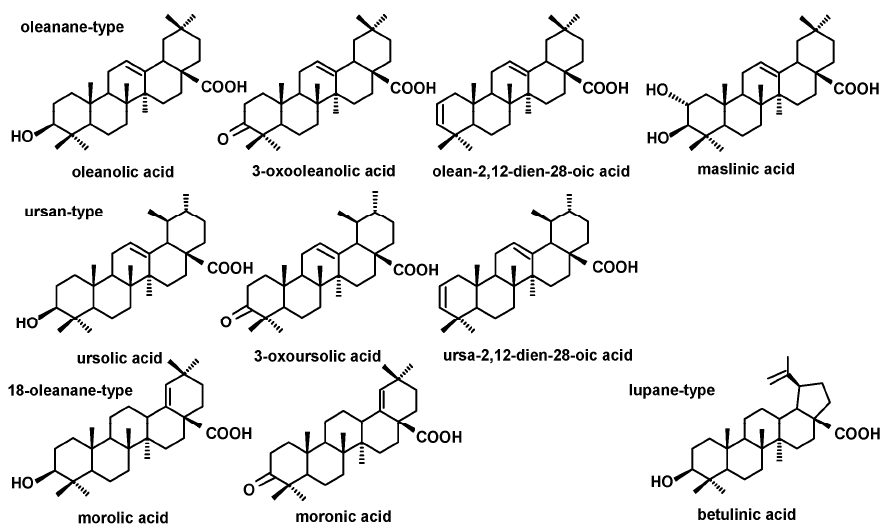
Figure 3. The structures of identified triterpenoid acids. 2.2. The Content of Steroids and Triterpenoids in Cistus ladanifer and Cistus monspeliensis The steroid and triterpenoid profiles of analyzed leaf extracts of C. ladanifer and C. monspeliensis were similar. They contained the most typical phytosterols, i.e., campesterol, stigmasterol and sitosterol, accompanied by steroid ketones: sitostenone, stigmastan-3,6- dione and tremulone. The fraction of the neutral triterpenoids consisted only of α - and β - amyrins. In the fraction of the triterpenoid acids, ursolic and oleanolic acids were identified, along with 3-oxo-oleanolic acid and maslinic acid. In C. monspeliensis leaf extract, additionally the naturally occurring methyl ester of maslinic acid was identified in the fraction of the neutral triterpenoids. The results of the quantitative analysis of identified compounds are presented in Table 1. Table 1. Content of steroids and triterpenoids in Cistus ladanifer and Cistus monspeliensis leaves. Compounds/Category